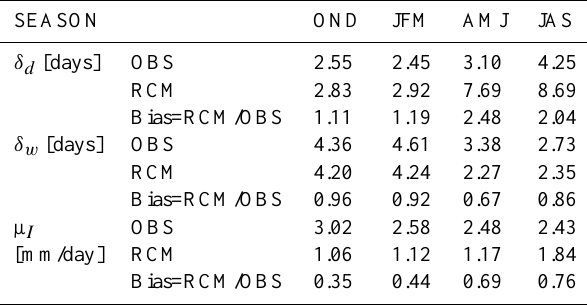
Table 1. Analysis of RCM predictive performance through the as- sessment of the model/observation bias of the following storm pa- rameters: mean storm intensity (µ I ), mean wet period ( δ w ) and mean dry period ( δ d ). The parameters are computed seasonally for the reference period 1961–1990.